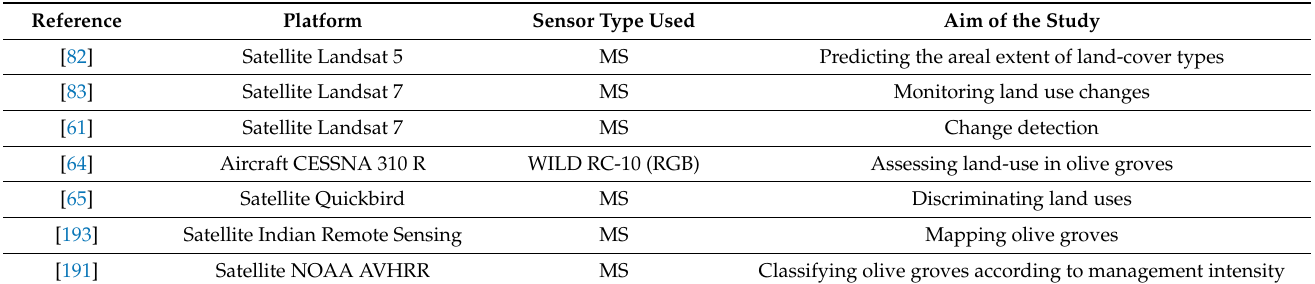
Table 4. References dealing with the identification and mapping of olive